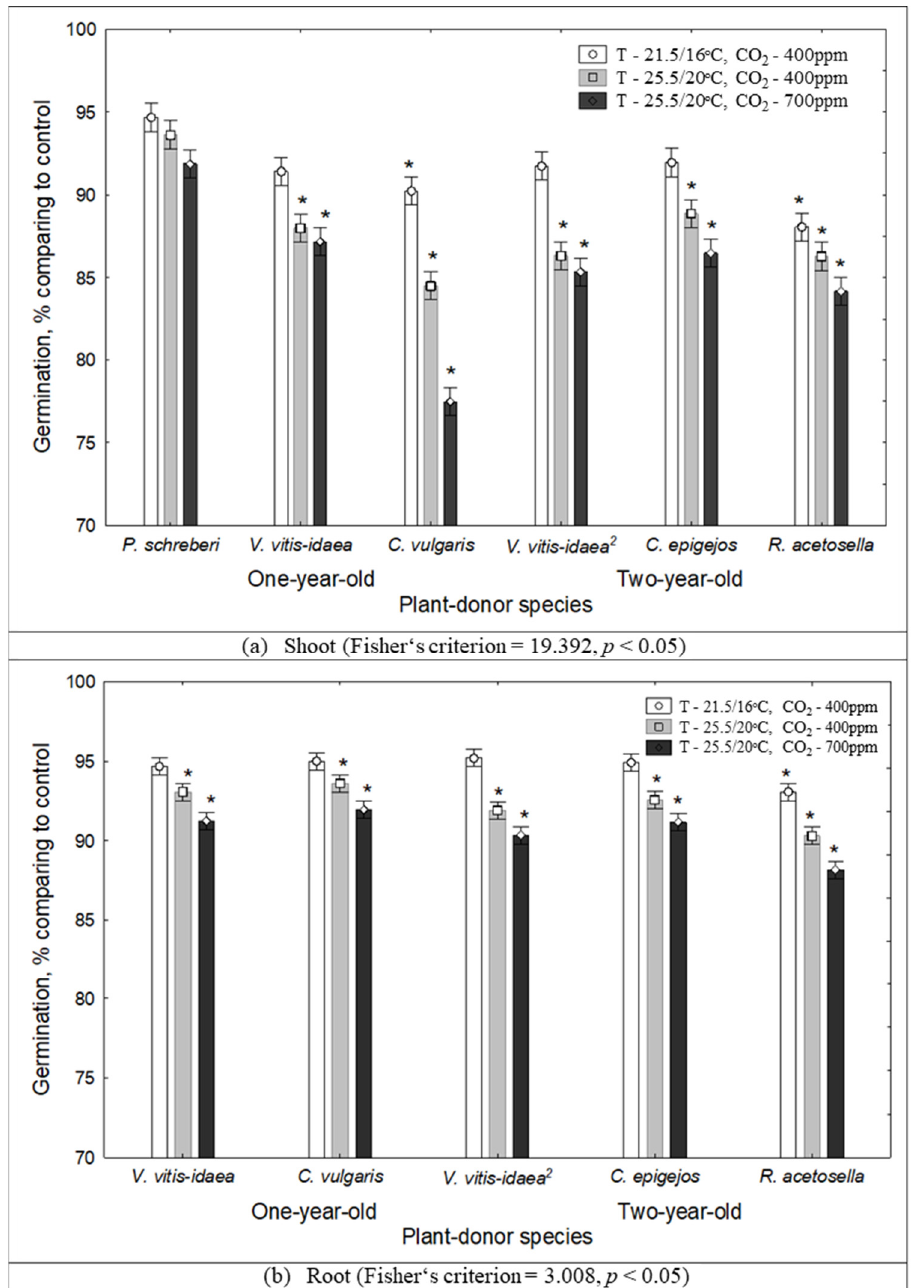
Figure 2. The impact of climate conditions on Scots pine seed germination rate under the effect of plant-donor shoot ( a ) and root ( b ) extracts (mean ± SD, *— p < 0.05 post-hoc LSD test). Control conditions (21.5/16 ◦ C and 400 ppm CO 2 concentration), temperature increases of 4 ◦ C compared to the current conditions (25.5/20 ◦ C and 400 ppm CO 2 concentration), increasing temperature with higher CO 2 concentration conditions (25.5/20 ◦ C and 700 ppm CO 2 ). ( 2 ) - dominant species of 2-year-old